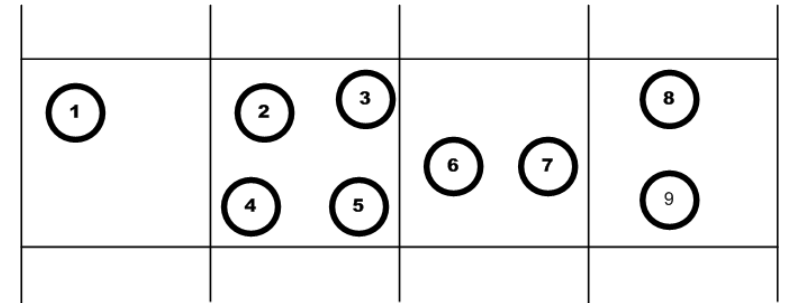
Figure 5. Example of virtual grid in